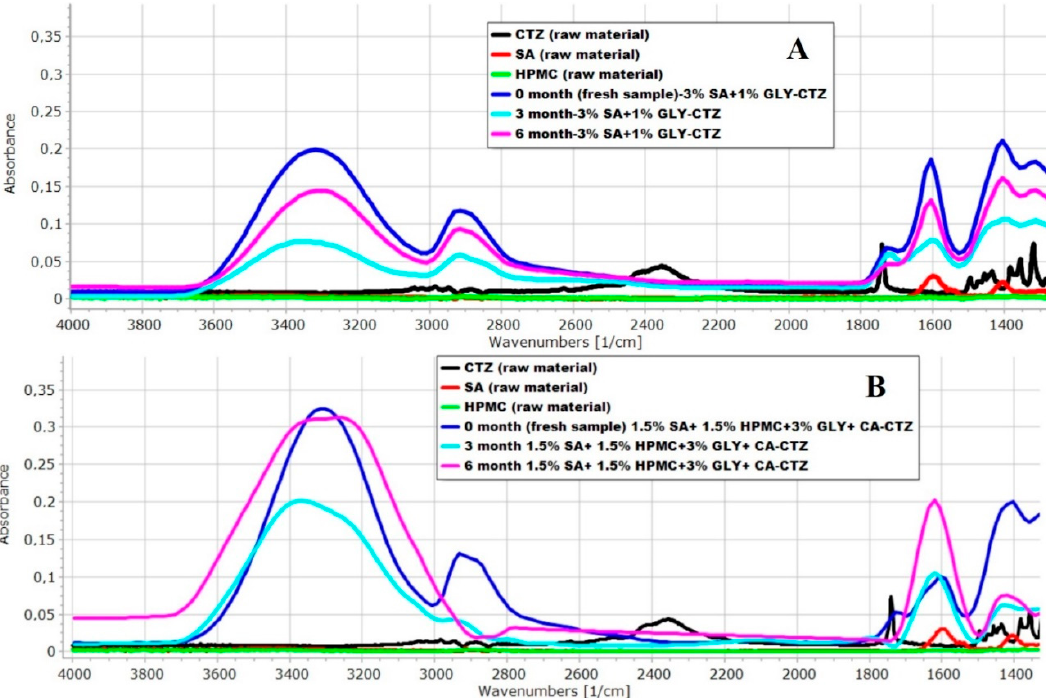
Figure 4 . Results of the FT-IR spectra of the prepared films (Part “ A ” Sample 1, Part “ B ” Sample 8) .